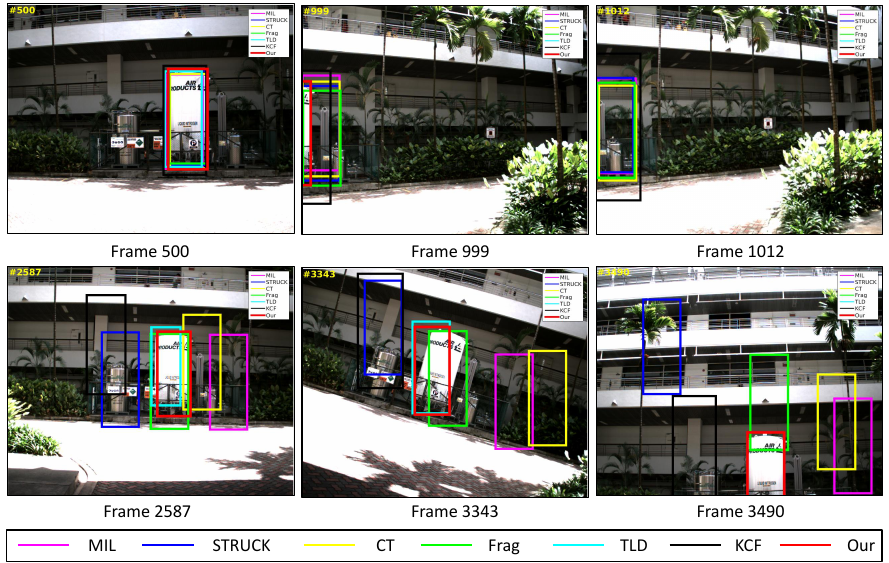
Figure 19. Some tracking results in the gas tank image sequence. The total number of frames: